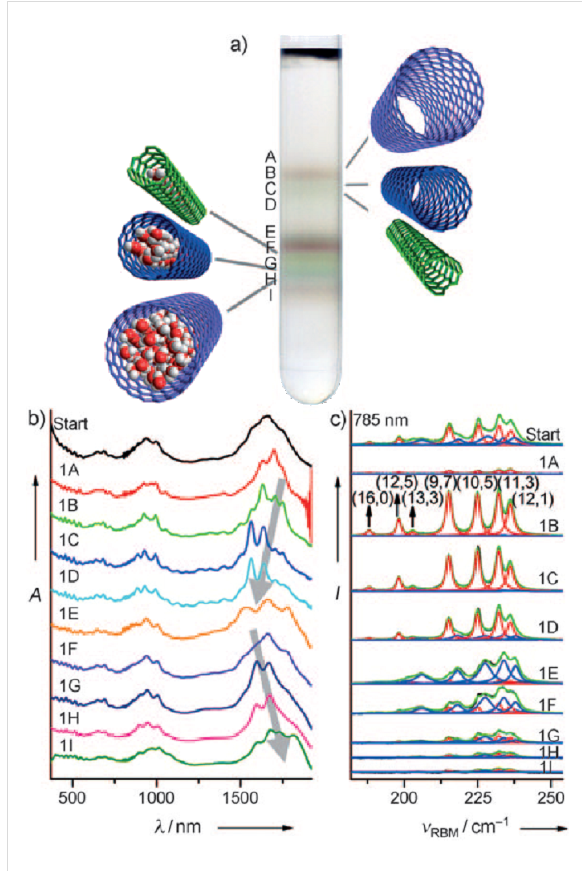
Figure 2: Sorting of empty and water-filled Arc SWCNTs (2% w/v SC). a) Centrifuge tube containing sorted Arc SWCNTs; b) Absorption spectra of the original solution and of the sorted fractions; c) Resonance Raman spectra of the different fractions excited at 785 nm. Reprinted with permission from [62]. Copyright 2011, Wiley VCH.